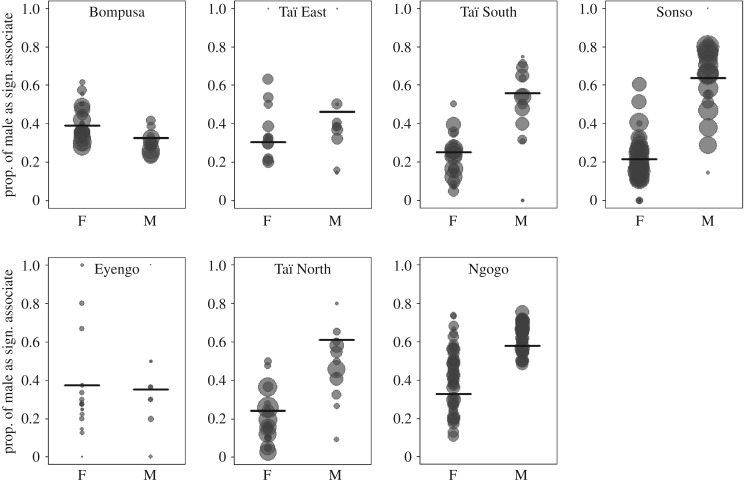
Proportion of males as significant associates averaged for each individual over all the three-month periods for males (M) and females (F) in each study community. Each dot represents an individual and the area of the dot is proportional to the number of three-month periods during which a given individual was observed. The darker the dots, the more data points overlay on this value. The horizontal segments indicate the fitted value resulting from Model 1b.